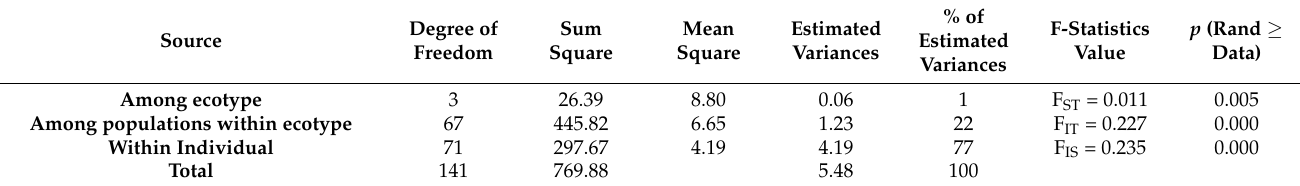
Table 4. Analysis of molecular variance calculated on the basis of the allelic distance matrix of Wright’s F-statistics among local chickens in the Centre-East (Konde ecotype), Centre-North, Sahel and South-West regions of Burkina